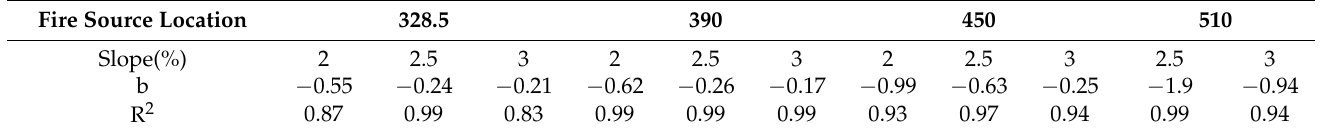
Figure 14. Dimensionless relation curve between the inlet air velocity at the shaft outlet and the shaft height. Table 4. Fitting coefficient of the dimensionless relation between the inlet air velocity at the shaft outlet and the shaft height.